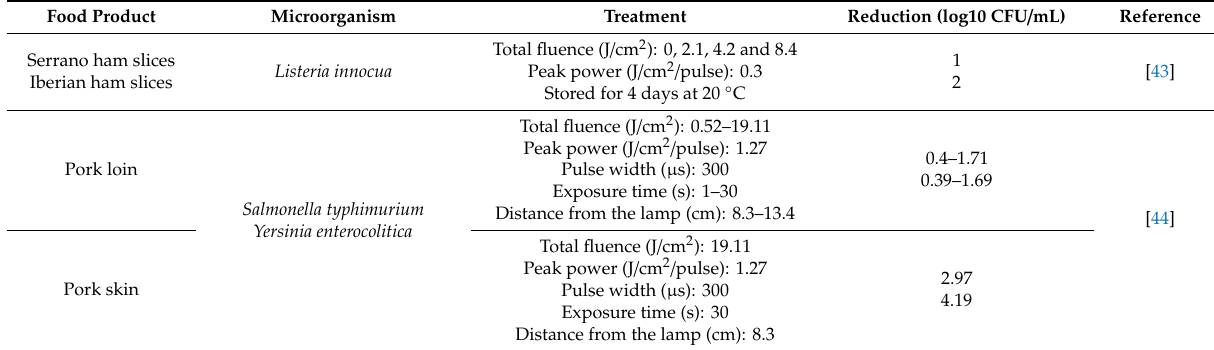
Table 2. Microbial reduction levels for meat after pulsed light